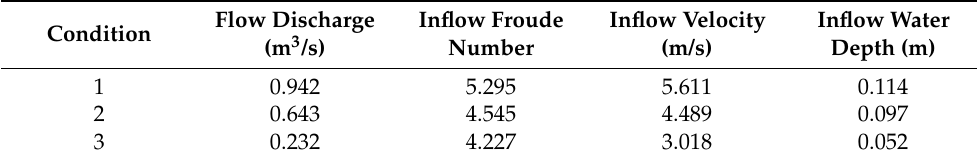
Figure 3. Schematic diagram of fluctuating pressure data-processing process. Table 1. Operating conditions.